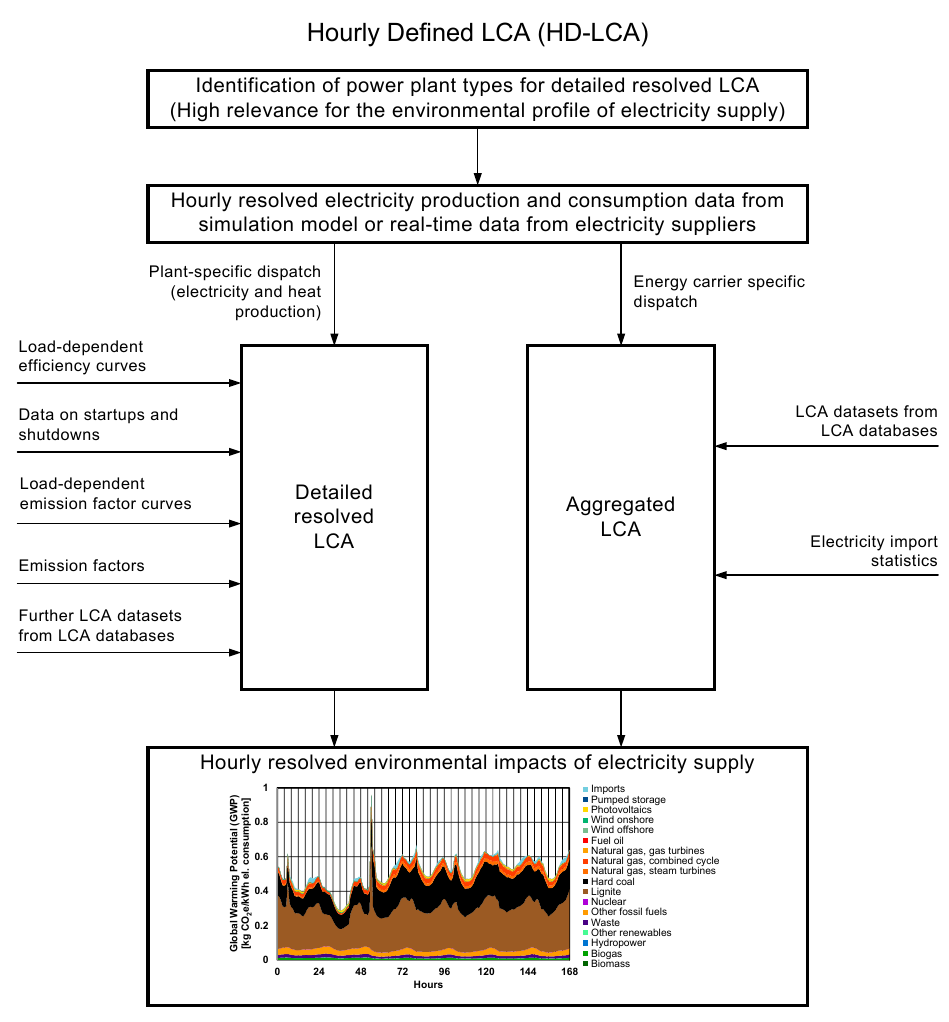
Figure 2. Main steps of the HD-LCA approach.